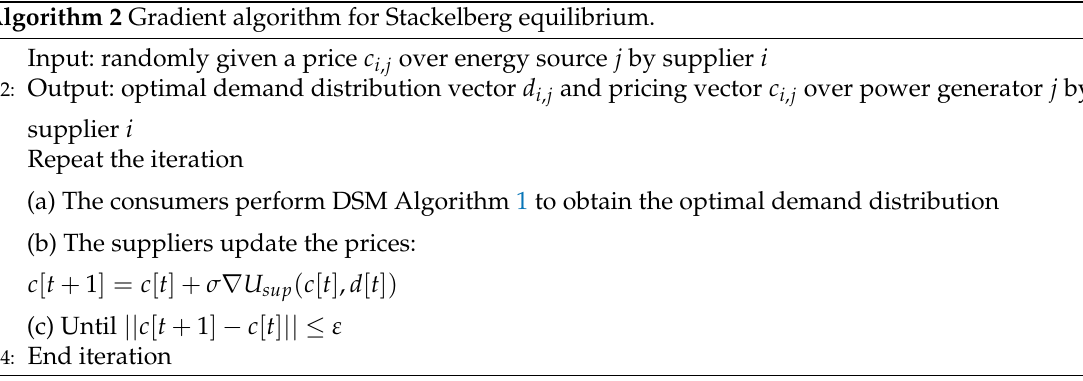
Algorithm 2 Gradient algorithm for Stackelberg